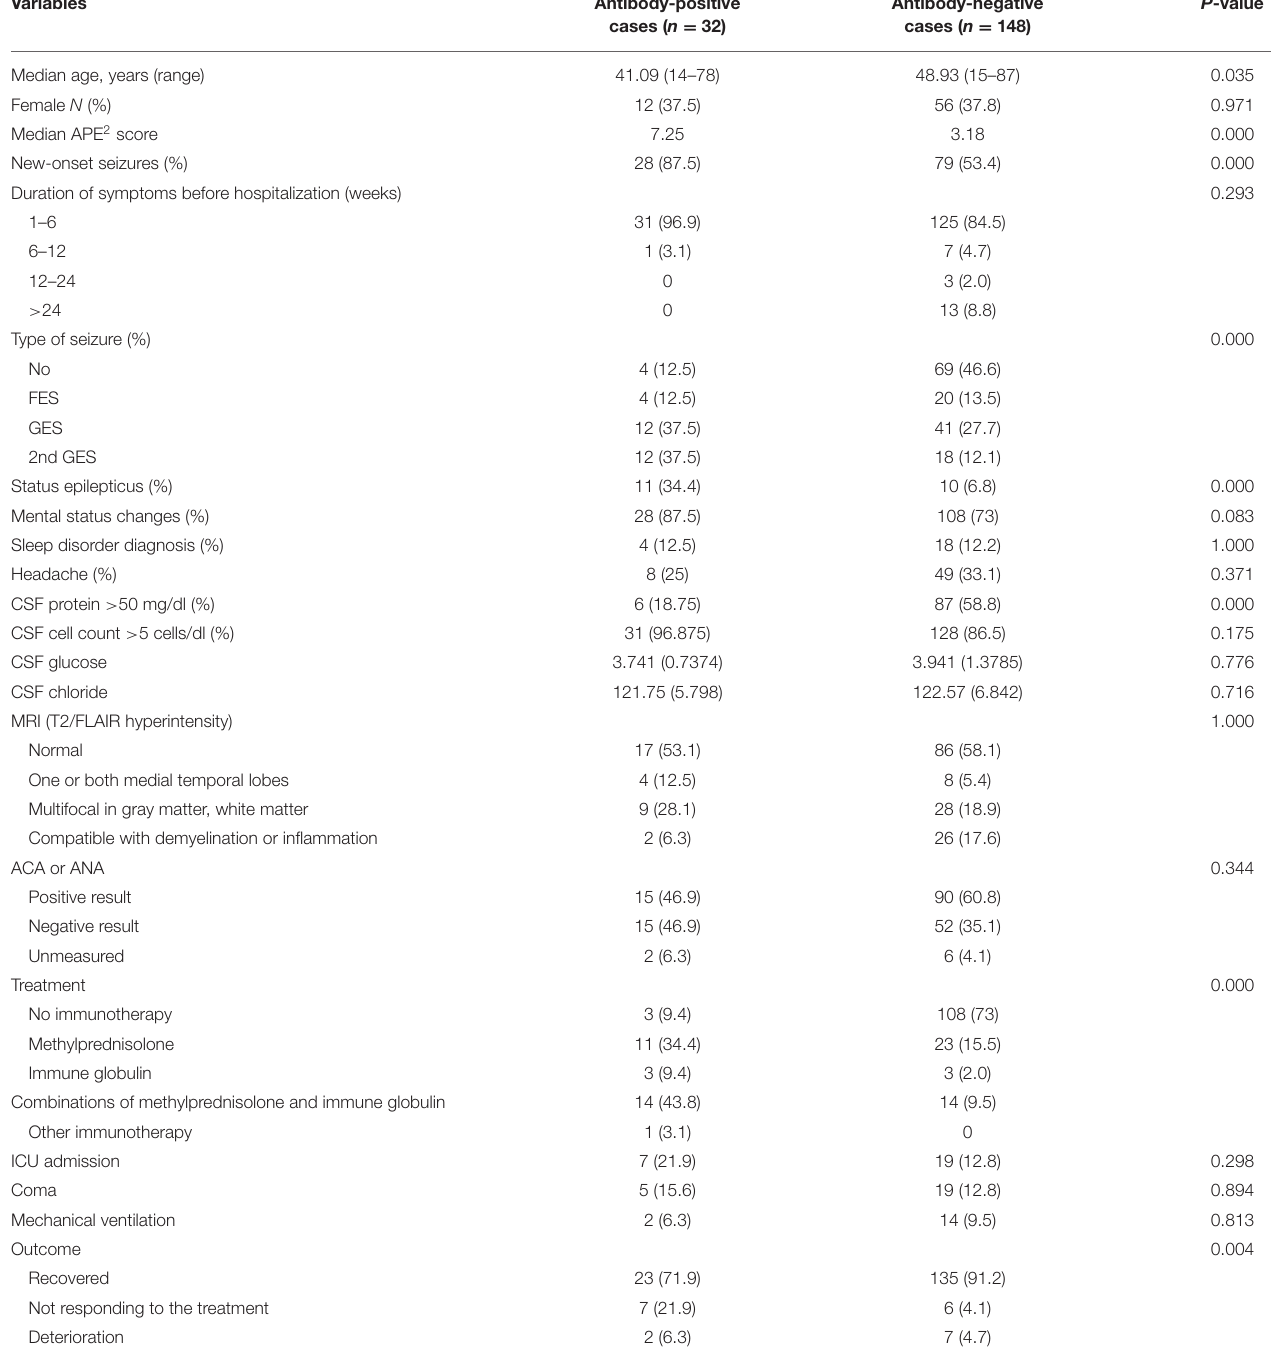
TABLE 1 | Clinical characteristics of patients in the